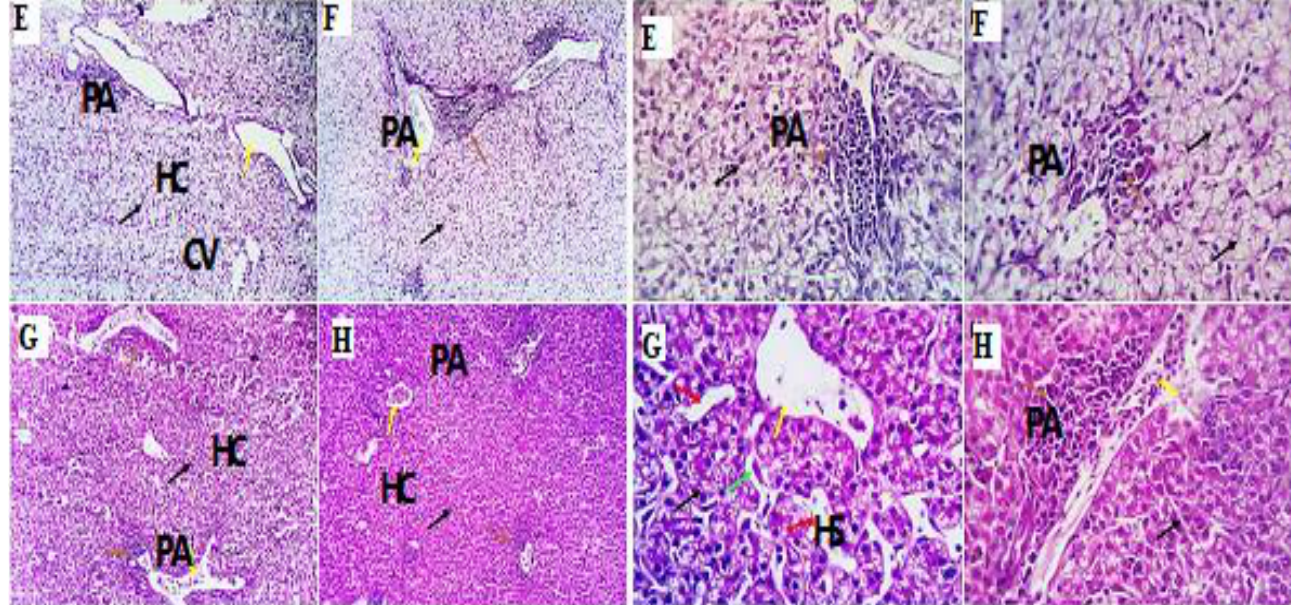
Figure 2. Photomicrograph from the liver of different experimental groups of chicken receiving 0 mg/kg lavender ( E ), 200 mg/kg ( F ), 400 mg/kg ( G ), and 600 mg/kg ( H ) showing the following: normal histological characterization of different structures, including portal area (PA, yellow arrow) hypertrophied Von Kupffer cells (green arrow), and hepatocytes (HC, black arrow), which are seen as small masses around the central veins (CVs), while a few round cells are seen as a natural immune response around the portal area (PA, arrow). Mild dilation of hepatic sinusoids (HS, red arrow) is seen in the group ( G ). H&E X 100, 400.